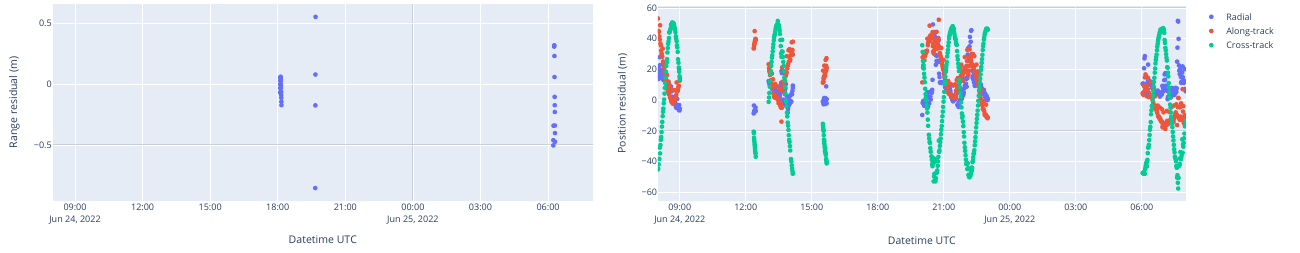
Figure 9. SLR range ( left ) and GPS position residuals ( right ) for a mixed SLR+GPS orbit determina- tion on TUBIN on 25 June 2022 from a 24 h measurement arc.